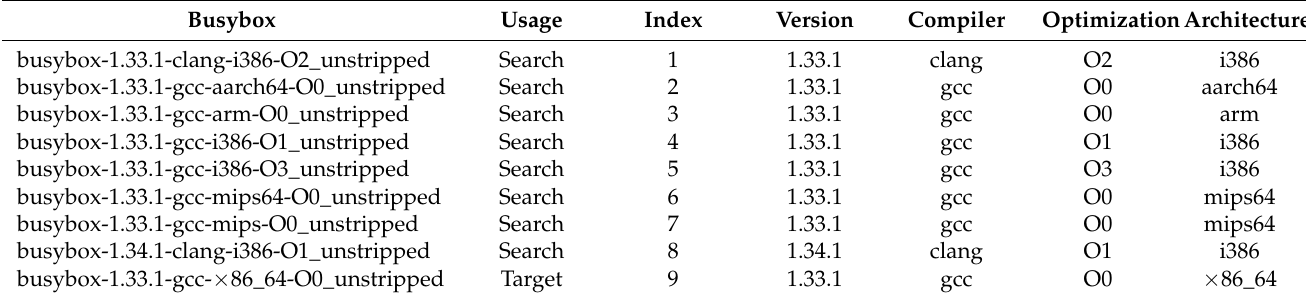
Table 3. Information list of Busybox.